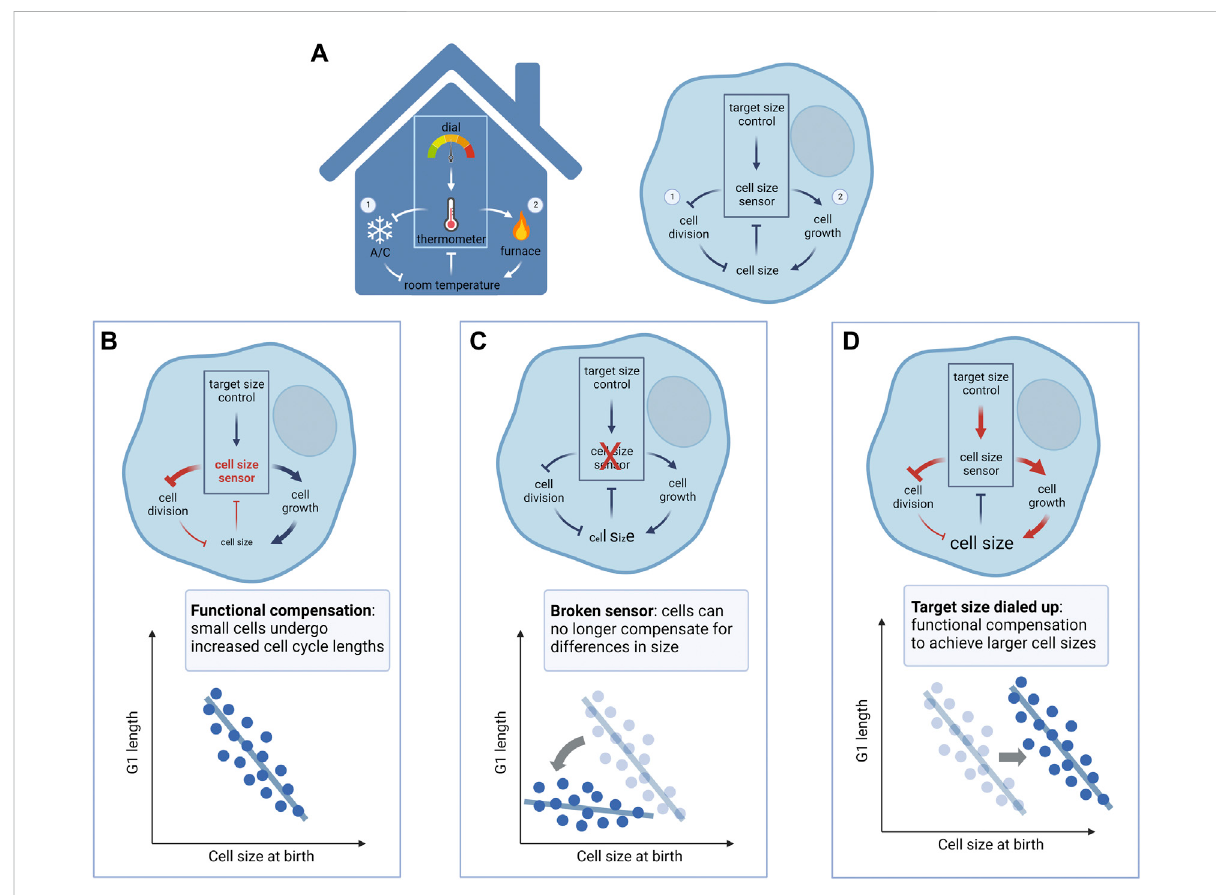
FIGURE 2 Amodelformammaliancellsizecontrol . (A) Cellsizeregulationsharessimilarcontrolcircuitsasathermostatthatcontrolsthetemperatureof aroom.Notethatanalogiesbetweencircuitcomponentsarebasedonthedirectionofregulation,i.e.,fastercelldivision/cellcyclealonereducescell size (turning on/up the air conditioner reduces room temperature), and faster cell growth alone increases cell size (turning on/up the furnace increasesroomtemperature).Leftpanel:Athermometermeasuresthetemperatureoftheroomandcomparesittothesetpointdeterminedby thedial.Iftheroomtemperatureislowerthanthesetpoint,thethermostatturnsonthefurnaceandturnsofftheairconditionertoheatuptheroom. Conversely, if the room temperature is higher than the setpoint, the thermostat turns off the furnace and turns on the air conditioner to cool the room down. This dual-arm negative feedback regulation on the furnace and air conditioner maintains the room temperature at the setpoint.